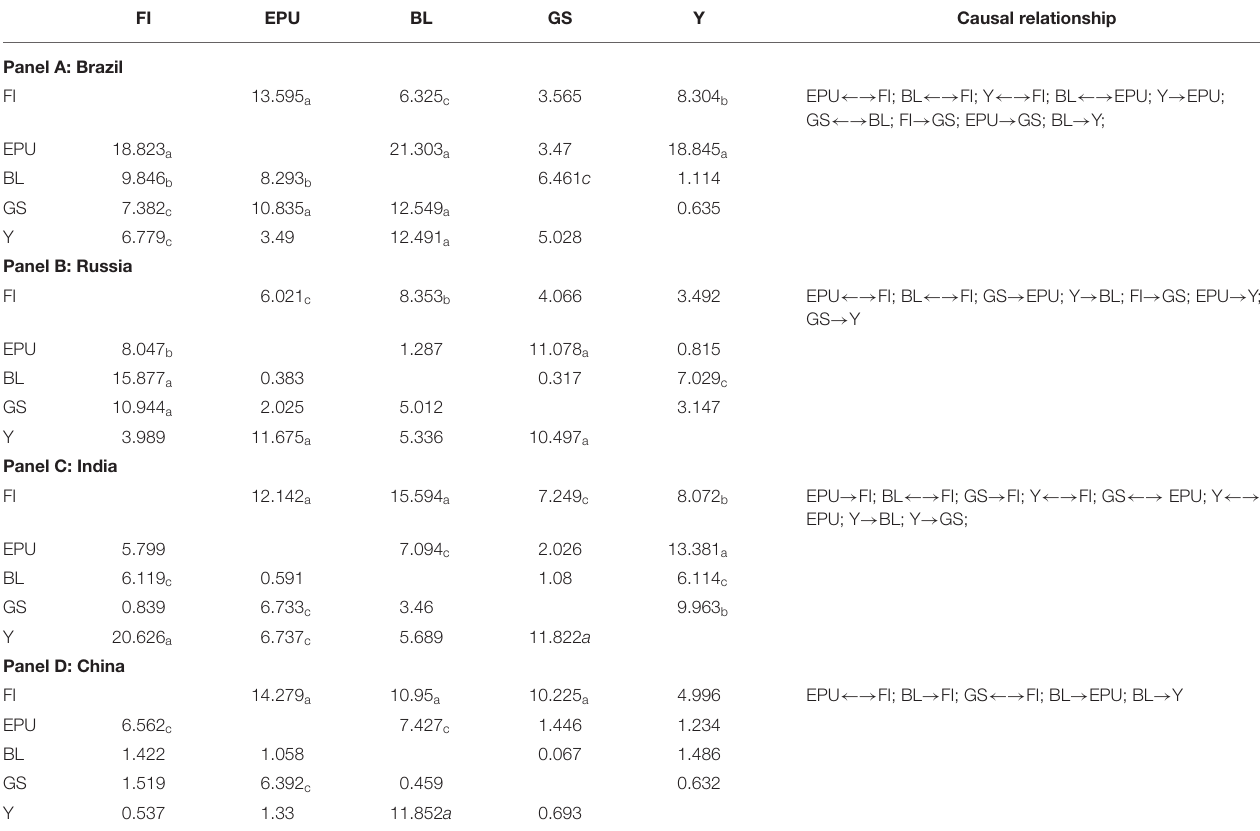
TABLE 7 | Results of causality test: financial innovation measured by M 3 /M 1